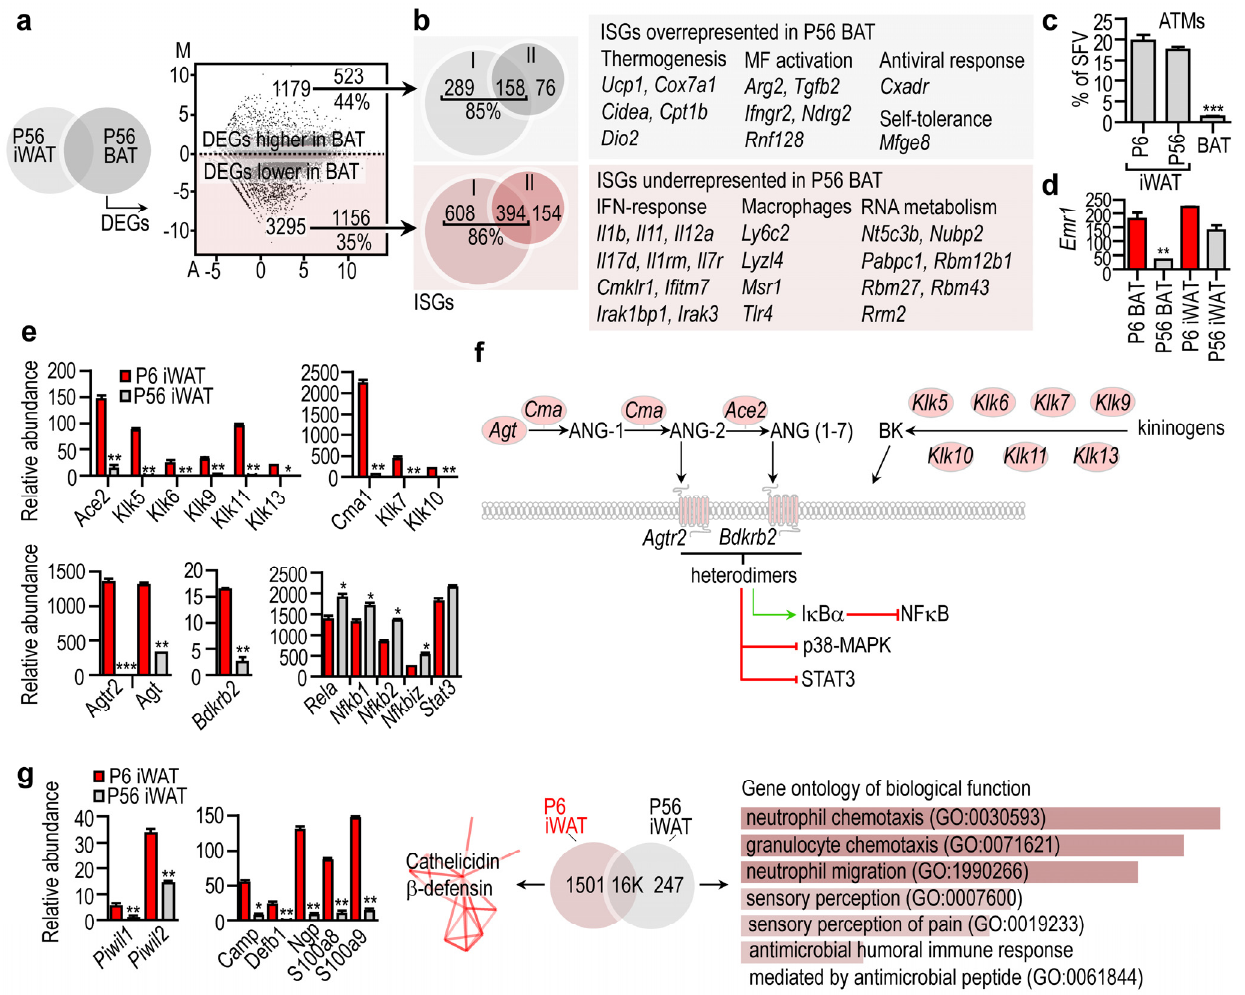
Figure 4. Immune-related gene transcripts in the BAT and in the iWAT. ( a ) P56 iWAT and P56 BAT were compared, and the DEGs were visualized in a scatter plot. Number of DEGs, and the percentage of interferon-stimulated genes (ISGs) are shown. ( b ) Representative ISGs overrepresented or underrepresented in BAT. ( c ) Percentage of adipose tissue macrophages (ATMs) within the stromal vascular fraction (SVF) of P6 iWAT, P56 iWAT and P56 BAT. *** p < 0.001, two-way ANOVA with Dunnett’s post hoc test, using P6 BAT as reference group ( d ) Expression level of the macrophage marker Emr1 , encoding F4/80 antigen. ** p < 0.01, two-way ANOVA with Dunnett’s post hoc test, using P6 BAT as reference group. ( e ) Expression level of genes associated with the local angiotensin and kininogen system. * p < 0.05, ** p < 0.01, *** p < 0.001, Student’s two-tailed unpaired t-test. ( f ) Scheme summarizing the cell compartment association of the gene products associated with the local angiotensin and kininogen system. All indicated gene products were overrepresented in P6 iWAT. ( g ) Left: Expression level of PIWI protein-encoding genes, and genes encoding cathelicidin and β -defensins. * p < 0.05, ** p < 0.001, Student´s two-tailed unpaired t-test. Middle: Cathelicidin and β -defensin gene network overrepresented in P6 iWAT. PPI enrichment p -value < 1.0 × 10 − 16 . Right: Gene ontology of DEGs overrepresented in P56 iWAT. Combined p -value < 0.01. In turn, 35% of the underrepresented DEGs in P56 BAT were ISGs, including the IFN-response genes interleukin 1b (Il1b) , Il11 , Il12a , interleukin-7-receptor (Il7r) ,